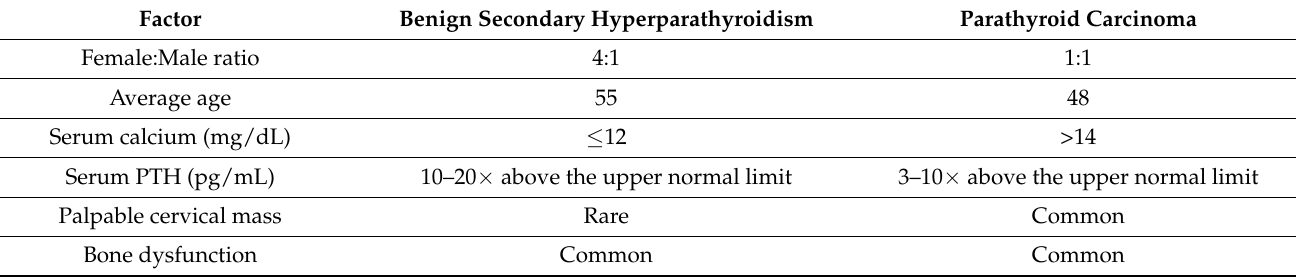
Table 2. Clinical and biological features of benign secondary hyperparathyroidism and parathyroid carcinoma